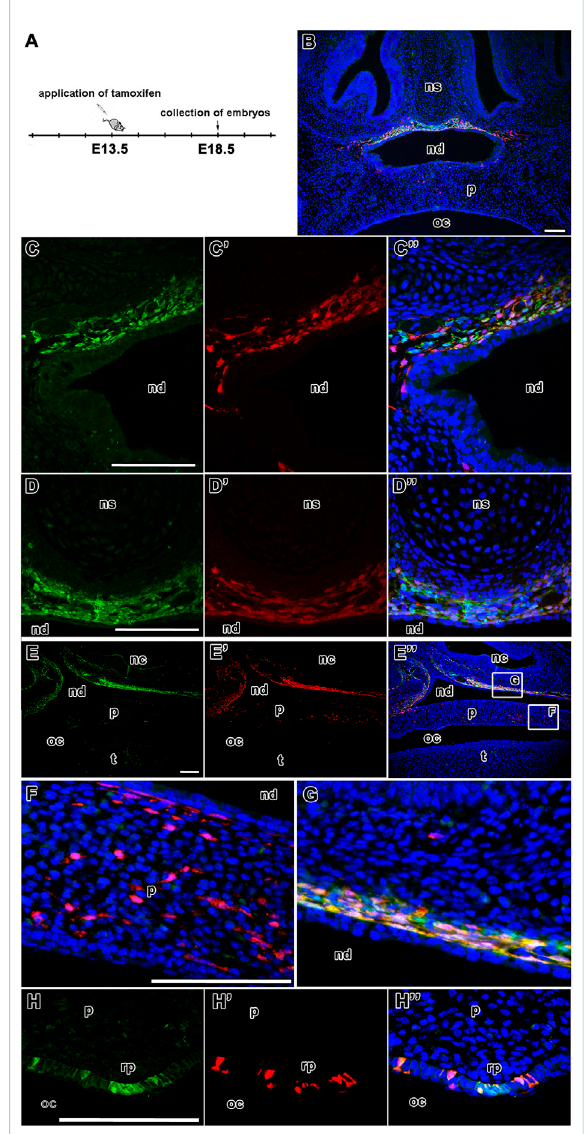
FIGURE 5 Fate of LGR5-positive cells during palatogenesis. Timeline of tamoxifen application and collection of samples (A) . Transversal sections of lineage tracing in the developing nasopharyngeal duct and palate of Lgr5-EGFP-CreERT2 (green color)and Rosa26- tdTomato reporter mice (red color) at E18.5 after tamoxifen administration (B) . The expression of LGR5/EGFP positive cells at fi nal time point at E18.5 in the mesenchyme beyond epithelium of nasopharyngeal duct (C, D) . LGR5/tdTomato positive cells at time point from E13.5 to E18.5 (C´,D´) and the overlap of